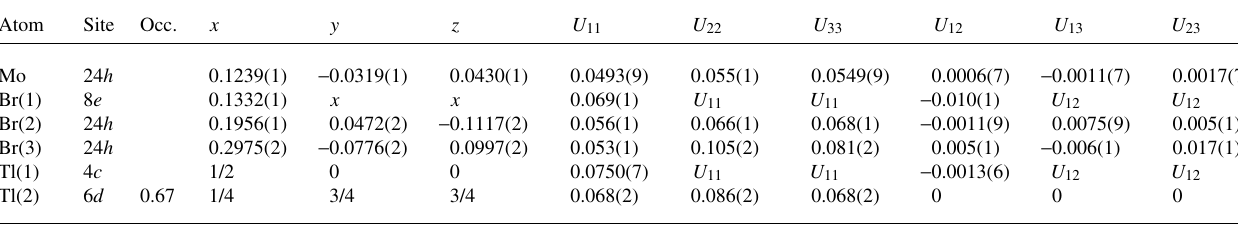
Table 2. Atomic coordinates and displacement parameters (in Å 2 )